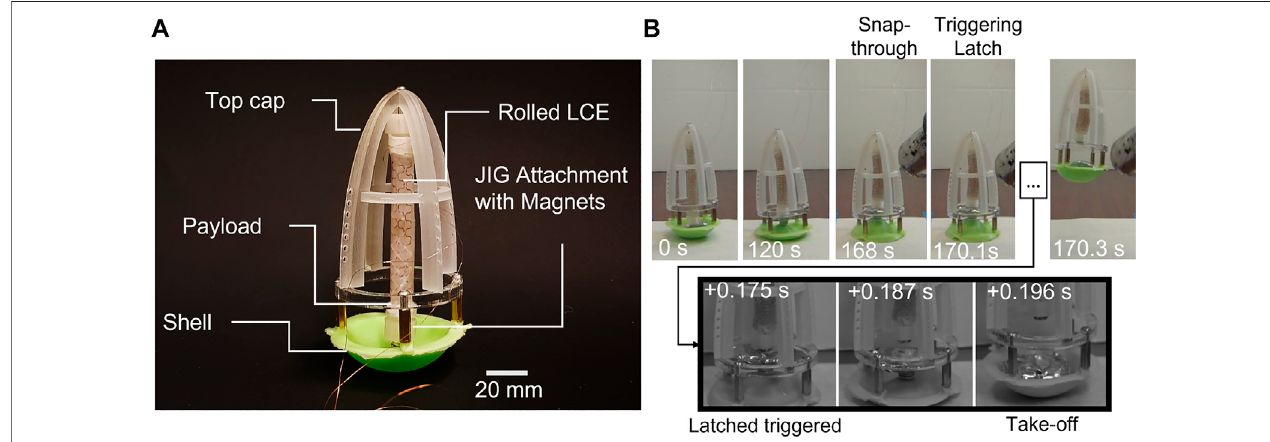
FIGURE 7 | Demonstration of the soft power ampli fi cation mechanism for a jumping robot. (A) Image of experimental system with key components labeled. (B) Top:FramesfromvideooftheLCEmuscleinvertingtheelasticshelluntilsnap-throughoccurred(0 – 168 s).Bottom:Framesfromhigh-speedvideoofthetriggeringofthe latching system, showing the rapid snap-back of the shell once it was decoupled from the LCE muscle.